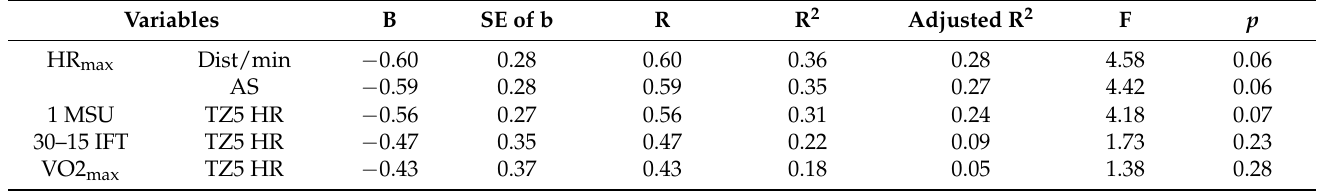
Table 7. Values of regression analysis explaining physical fitness assessment on performance variables and locomotor demands for selected futsal players.